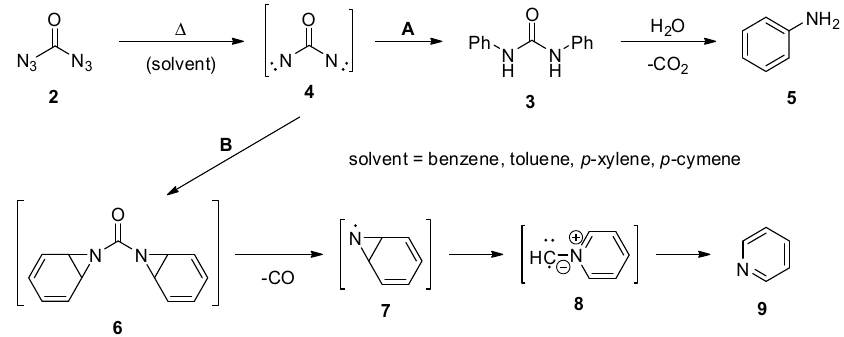
Scheme 2. Thermal reactions of carbonyl diazide ( 2 ) in aromatic hydrocarbons.